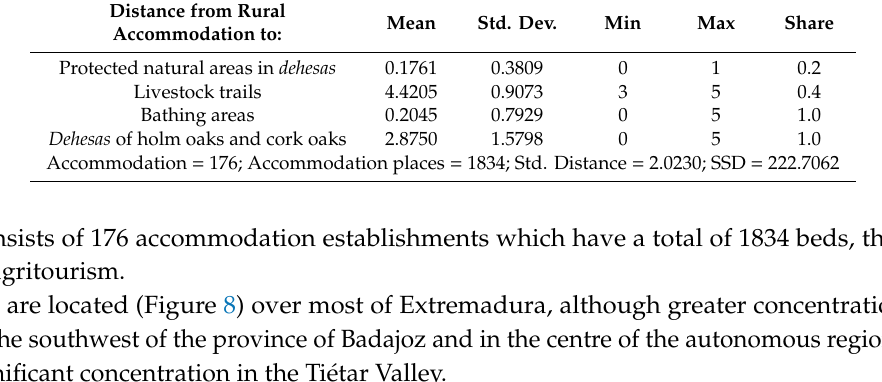
Table 9. Overall variable statistics (Group 2).